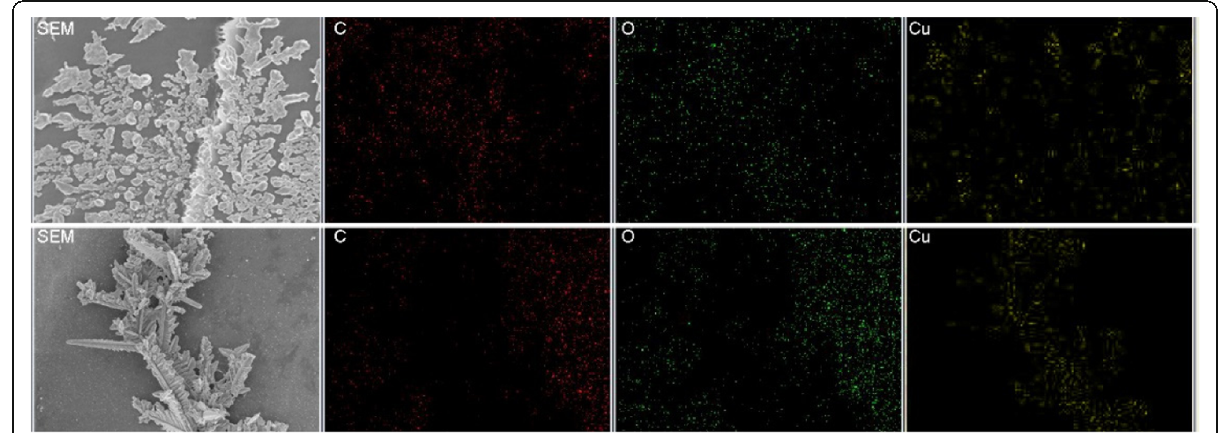
Fig. 6 SEM/EDS analysis of Cu distribution in wood structure. The top line is the analysis of the secondary structures on wood lumen wall and the bottom line is the analysis of the main structures on wood lumen wall